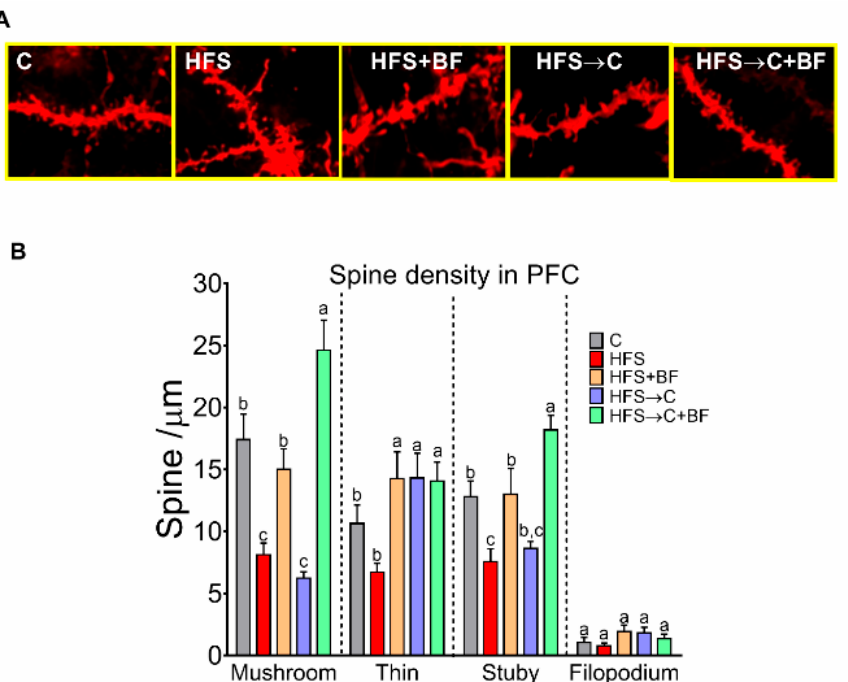
Figure 10. Dendric spine density increased in the prefrontal cortex with bioactive foods consumption. ( A ) Representative images of dendritic segments from neurons analyzed by NeuronStudio Software (NIH), ( B ) mushroom, thin, stubby, and filopodia spine density in prefrontal cortex of rats fed control ( C ) or high fat diet + 5% sucrose (HFS) with or without bioactive foods. Data are expressed as the mean ± SD. Mean values with different letters show statistical differences between each other. Data were analyzed by one-way ANOVA followed by Tukey post-hoc test. Results were considered statistically significant at p < 0.05.